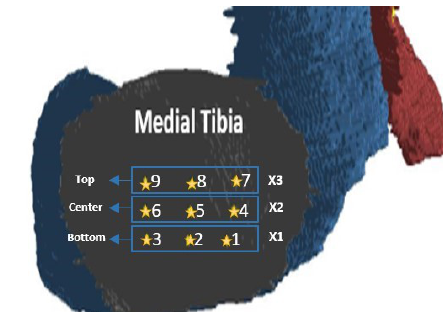
Figure 2. CDI locations and the 3 corresponding manual segmentation slices (X1, X2, and X3) on medial